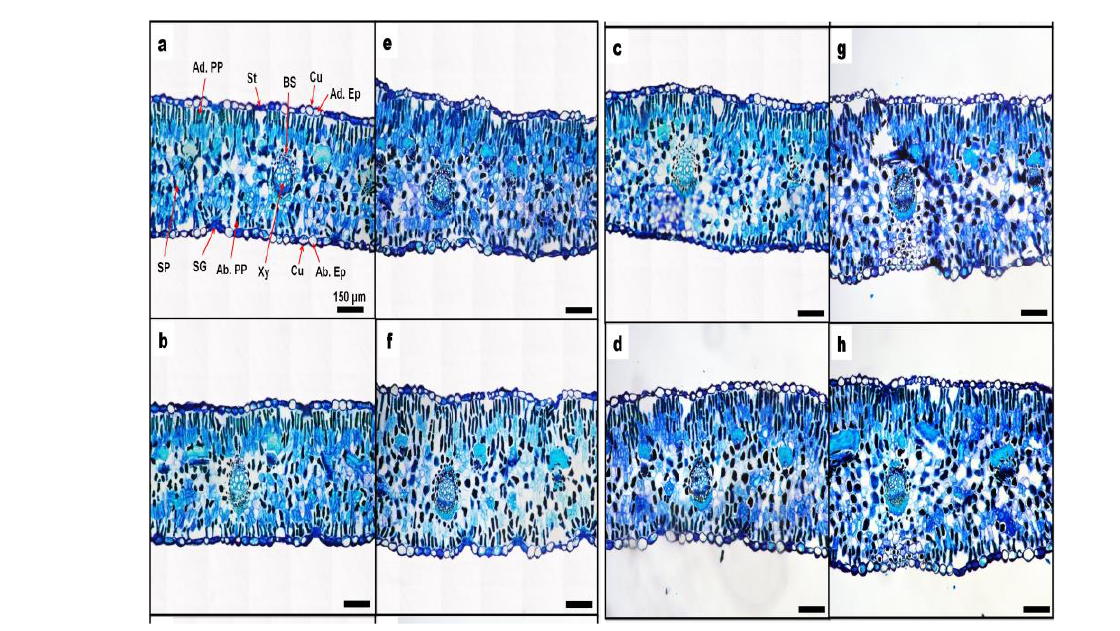
sc ribed by Duncan’s test.